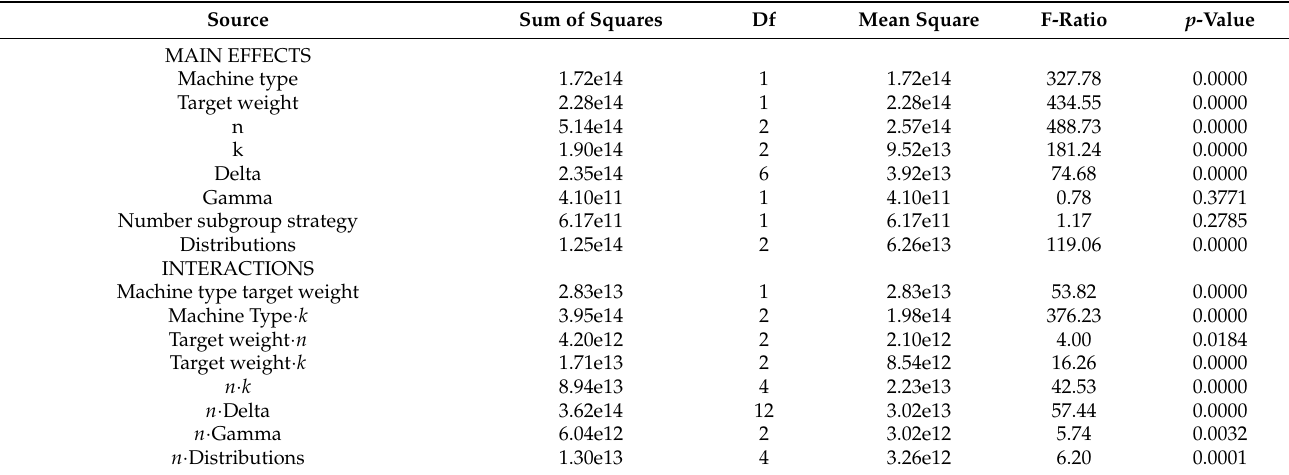
Figure 6. Adjusted box plot of the coefficient of variability by factors. Table 8. ANOVA for CVpaqT - sum of squares type